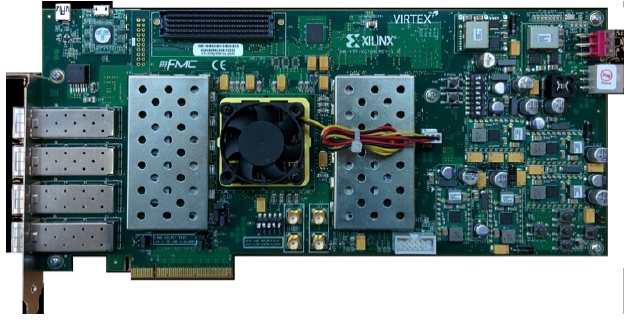
Figure 2. Image of the printed board—the designed FPGA-based “Calculator”.